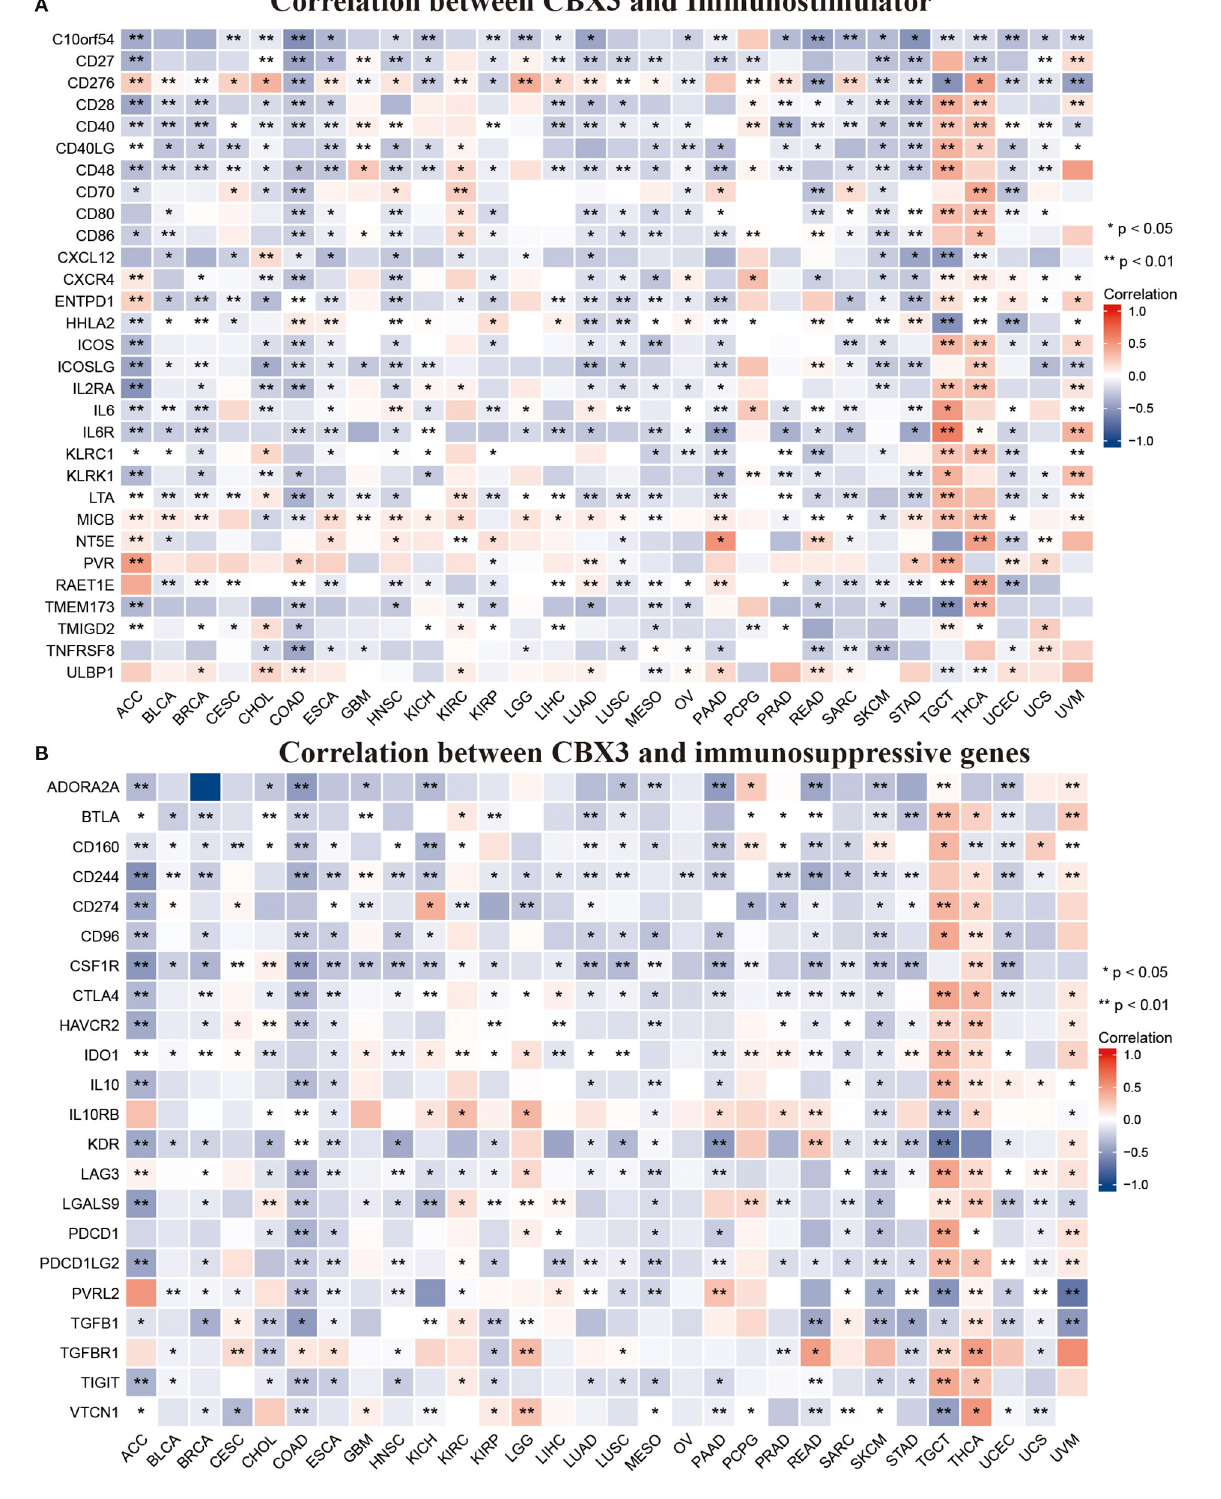
Frontiers in Medicine |